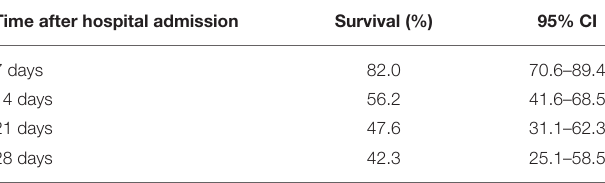
TABLE 1 | Cumulative survival rates in patients with severe